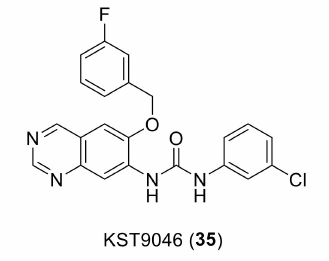
Figure 13. Chemical structure of compound KST9046 ( 35